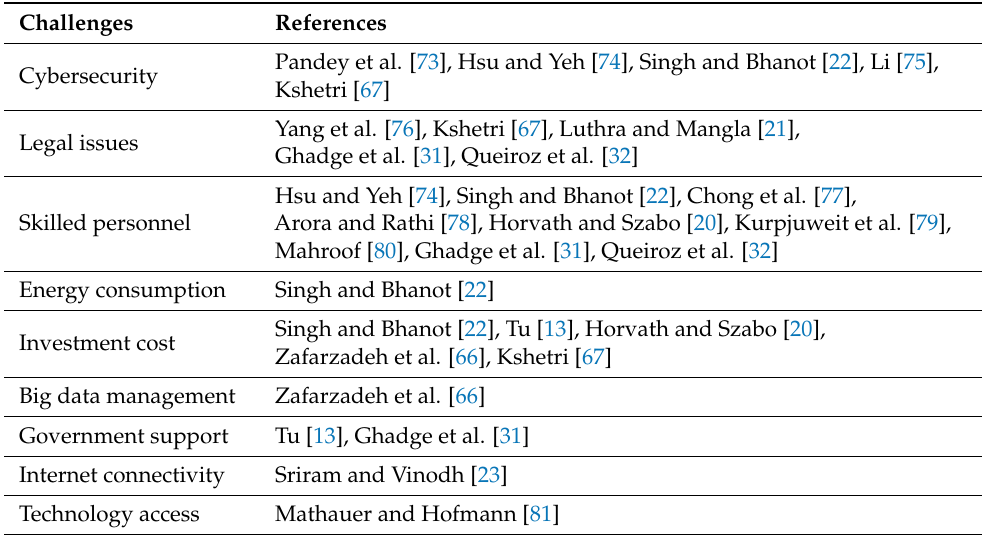
Table 5. Challenges to digitalization in the logistics